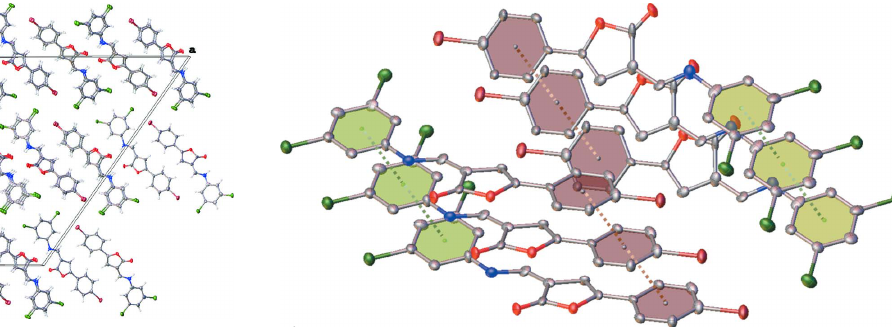
Figure 2 The crystal packing of the title compound, viewed along the b axis.